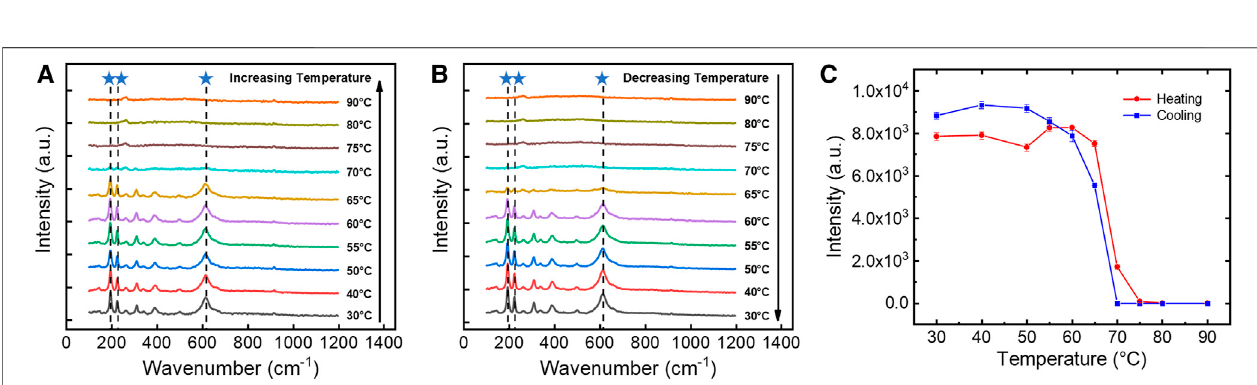
FIGURE 5 | For epitaxial VO 2 fi lms on c -plane sapphire substrates, the lattice constants a (A) , b (B) , and c (C) , and the included angle β (D) as a function of temperature. The solid square and circle represent the heating process and solid cooling process, respectively. The shaded area represents the structural phase transformation (SPT) region.